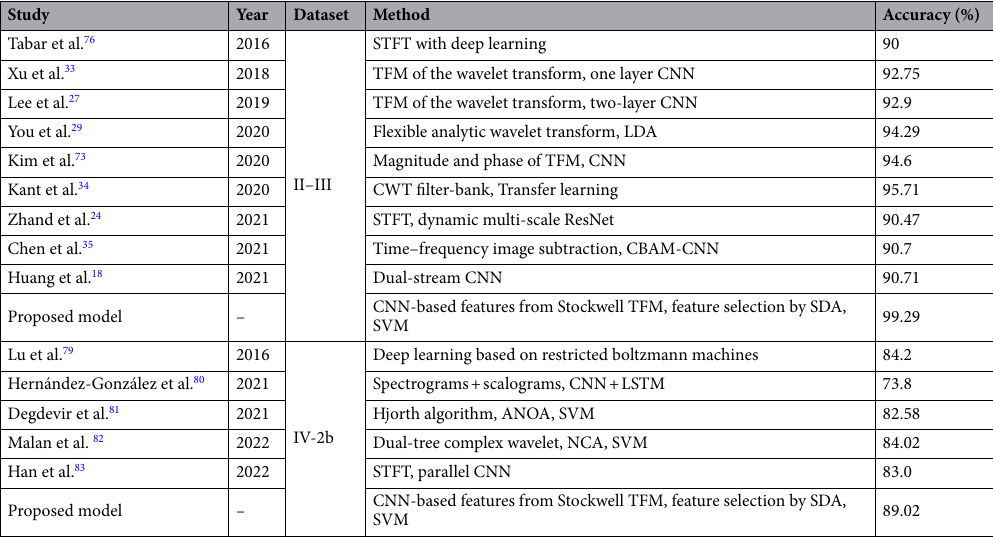
Table 13. Performance comparison of various